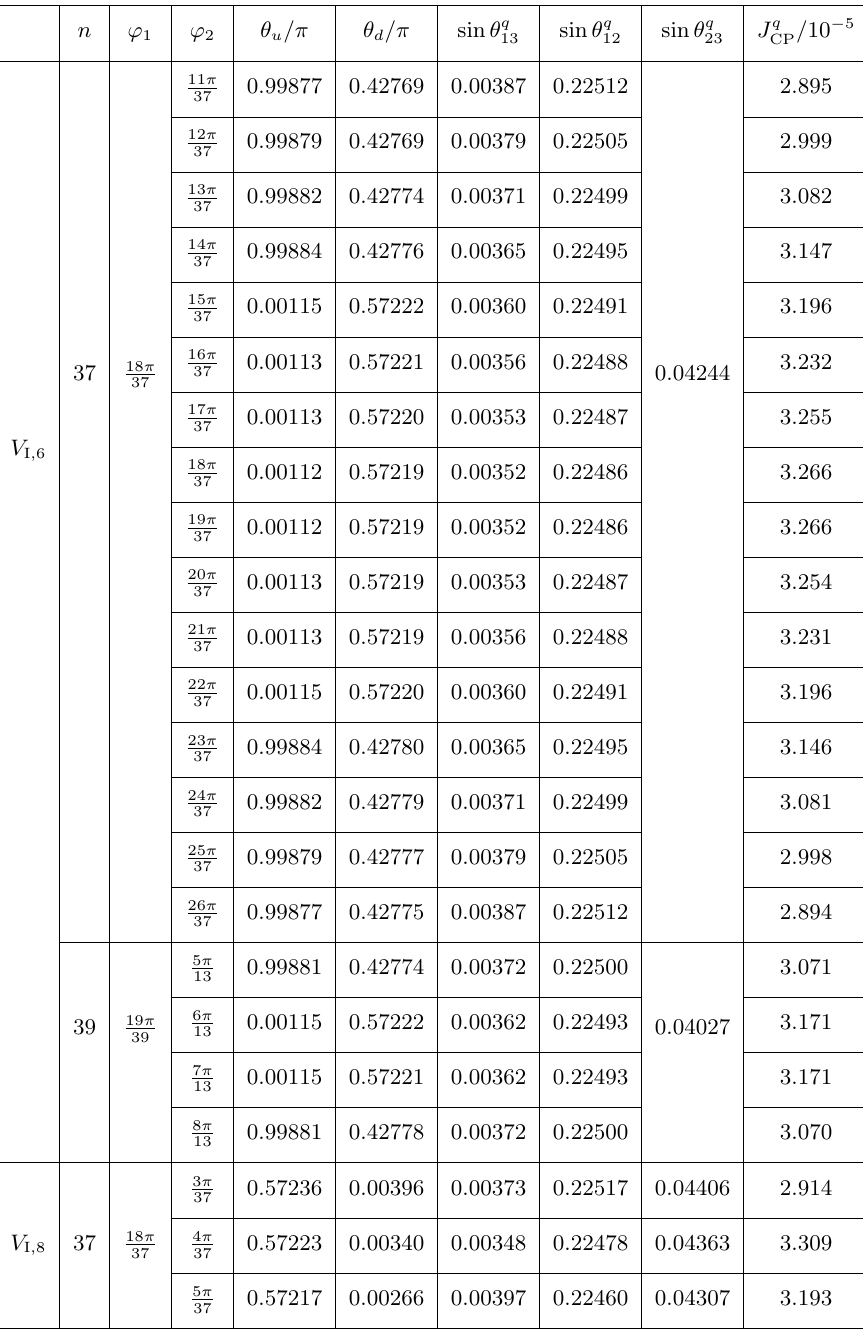
Table 10 . Results for the quark mixing parameters obtained from the mixing patterns V I ; 6